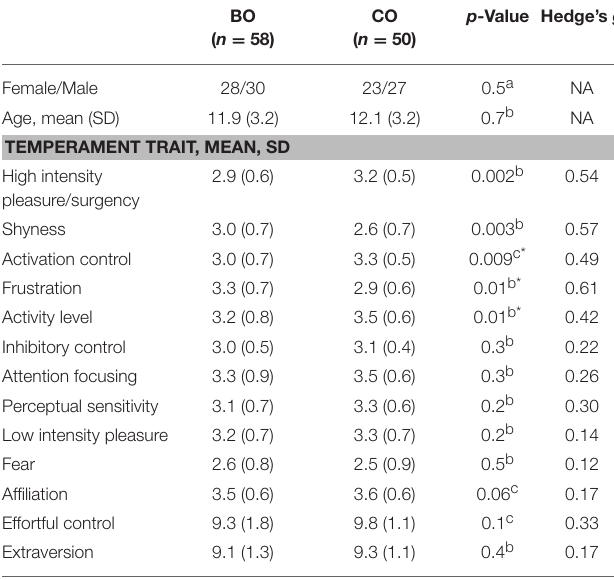
TABLE 5 | Temperament traits of offspring.